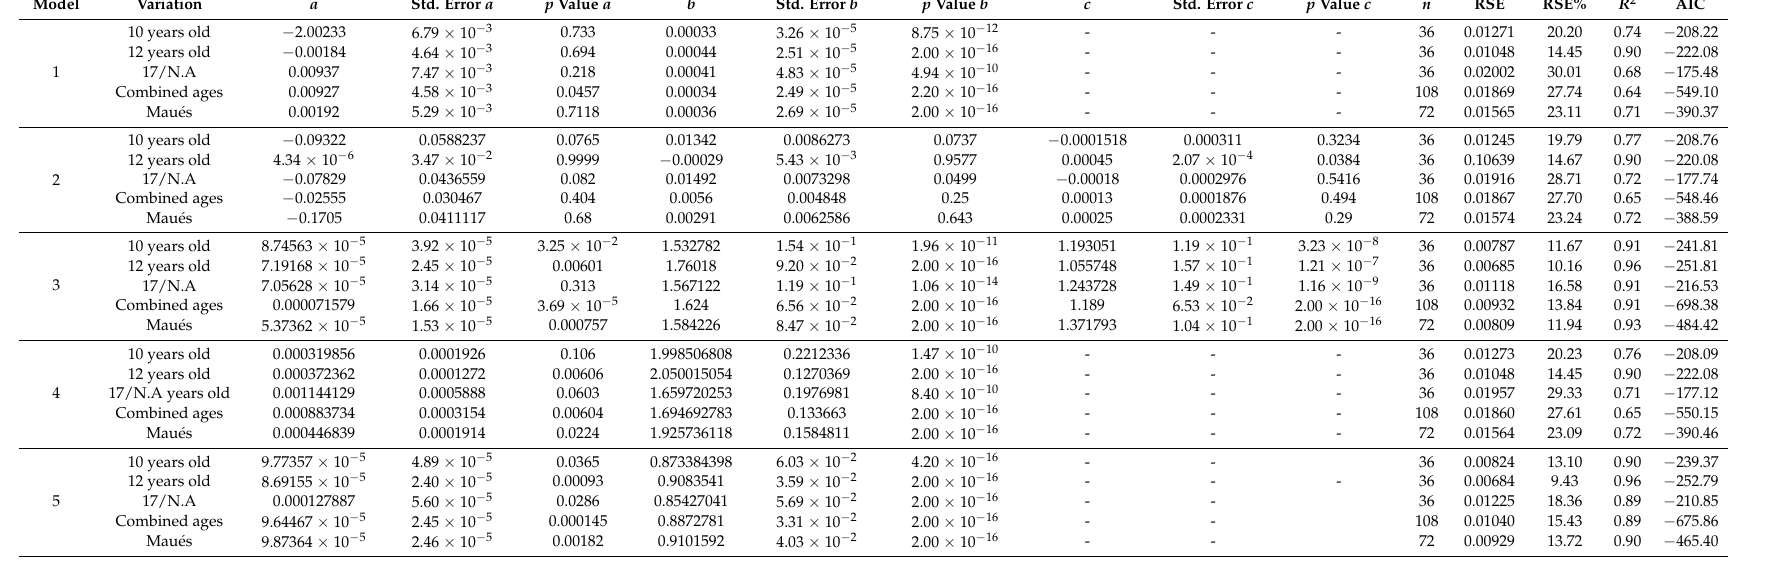
Table A2. Test results for the five models assayed for tree volume calculation for each category containing parameters calculated for each equation ( a , b , and c ); Significance of the coefficients ( p value); Standard error of the coefficients (std error.); Number of sample trees used to calculate equation ( n ); Residuals (RSE and RSE%), Coefficient of determination ( R 2 ) and Akaike index (AIC). N.A means Novo Aripuan ã